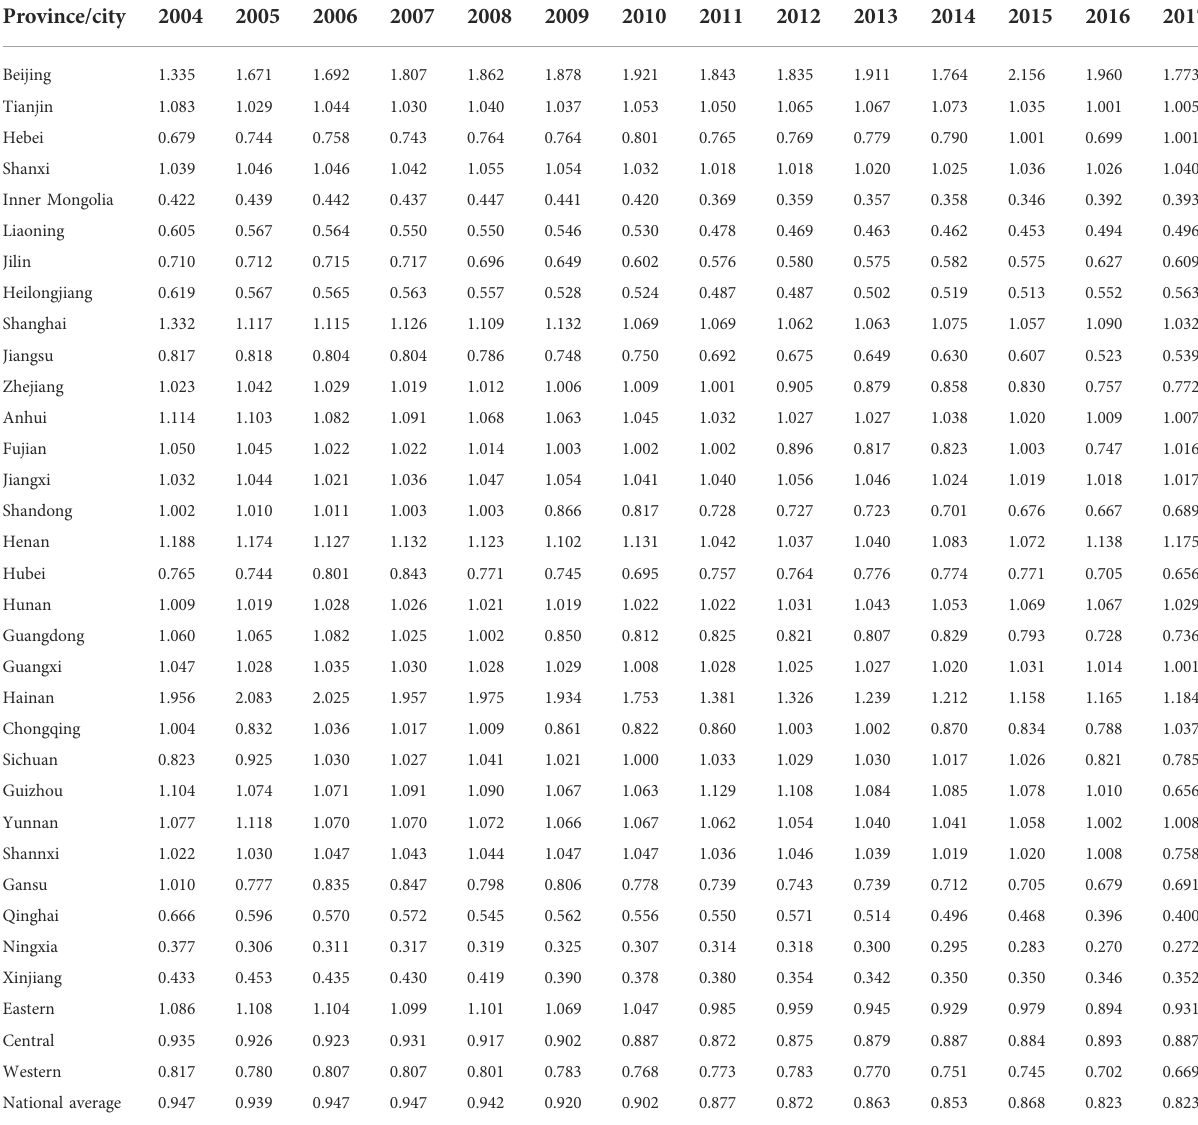
TABLE 3 Stage 1 results of ecological well-being performance of 30 provinces (autonomous regions and municipalities) in China from 2004 to 2017.